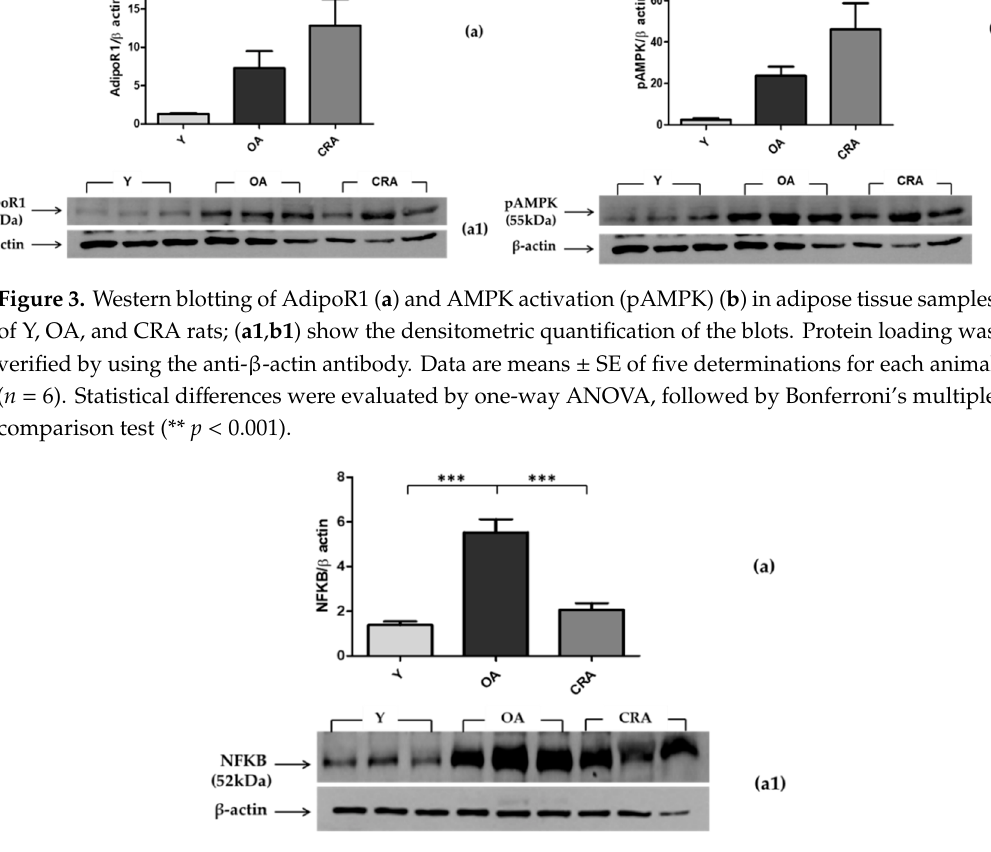
Figure 4. Western blotting of NF κ B ( a ) in adipose tissue samples of Y, OA, and CRA rats; ( a1 ) shows the densitometric quantification of the blots. Protein loading was verified by using the anti- β -actin antibody. Data are means ± SE of five determinations for each animal ( n = 6). Statistical differences were evaluated by one-way ANOVA, followed by Bonferroni’s multiple comparison test (*** p < 0.0001).